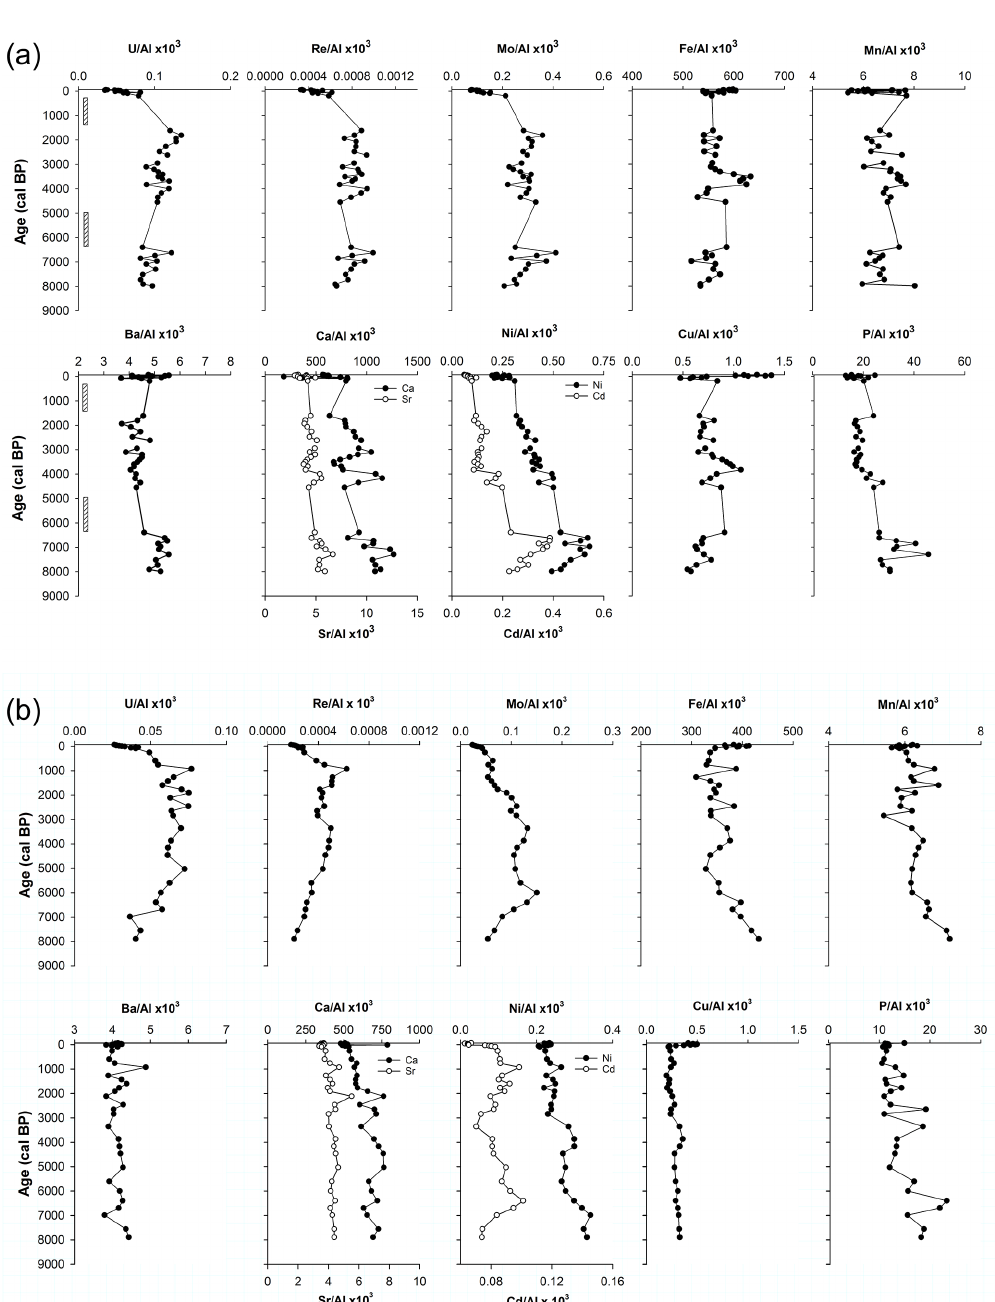
Figure 8. Downcore trace element variations in (a) Guanaqueros Bay (BGGC5) and (b) Tongoy Bay (BTGC8), off Coquimbo (30 ◦